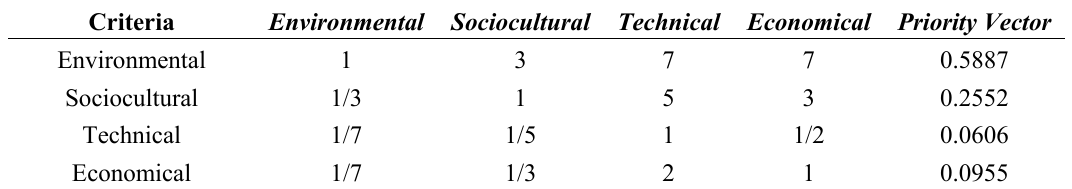
Table 3. Pairwise comparison matrix of the key criteria with regards to the goal.